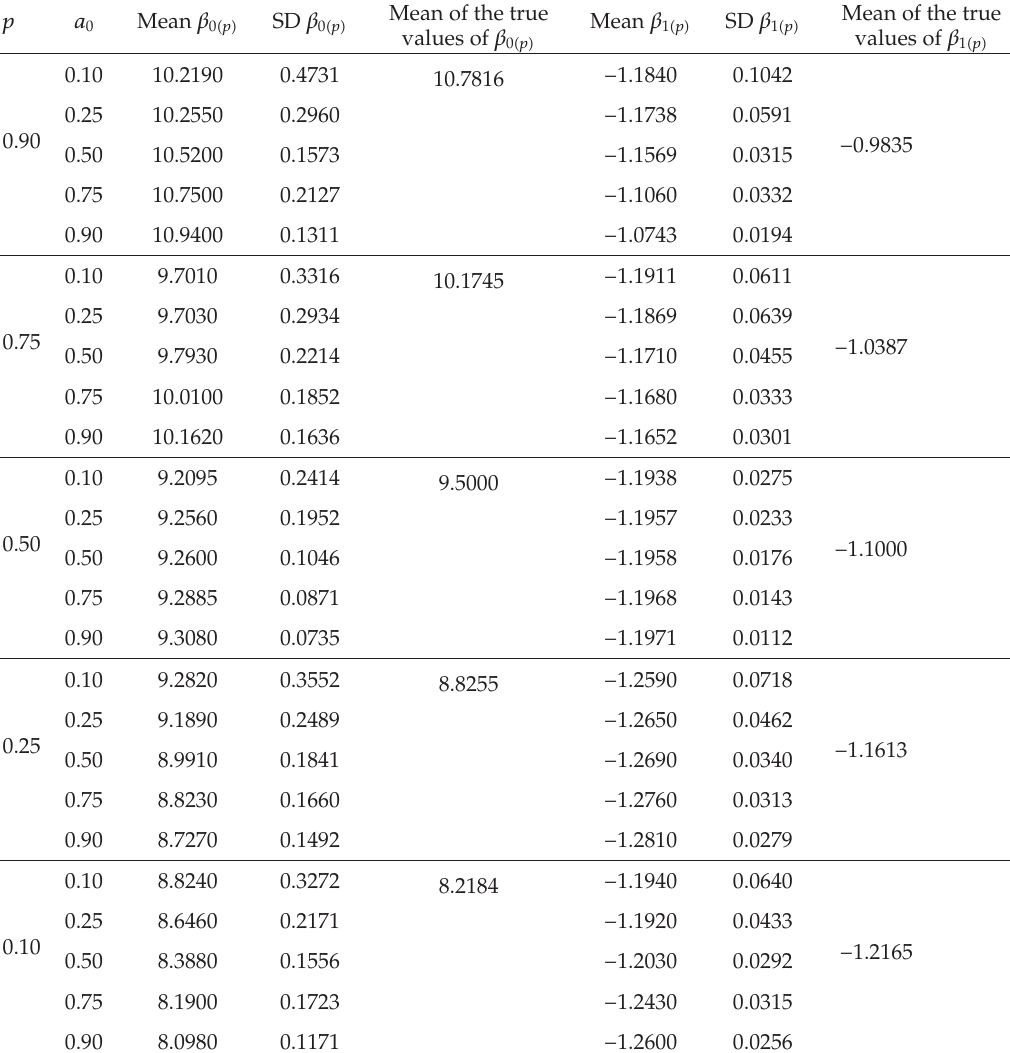
Table 2: Posterior means, posterior standard deviations (cid:2) SD (cid:5) , and mean of the true values of β (cid:2) p (cid:5)